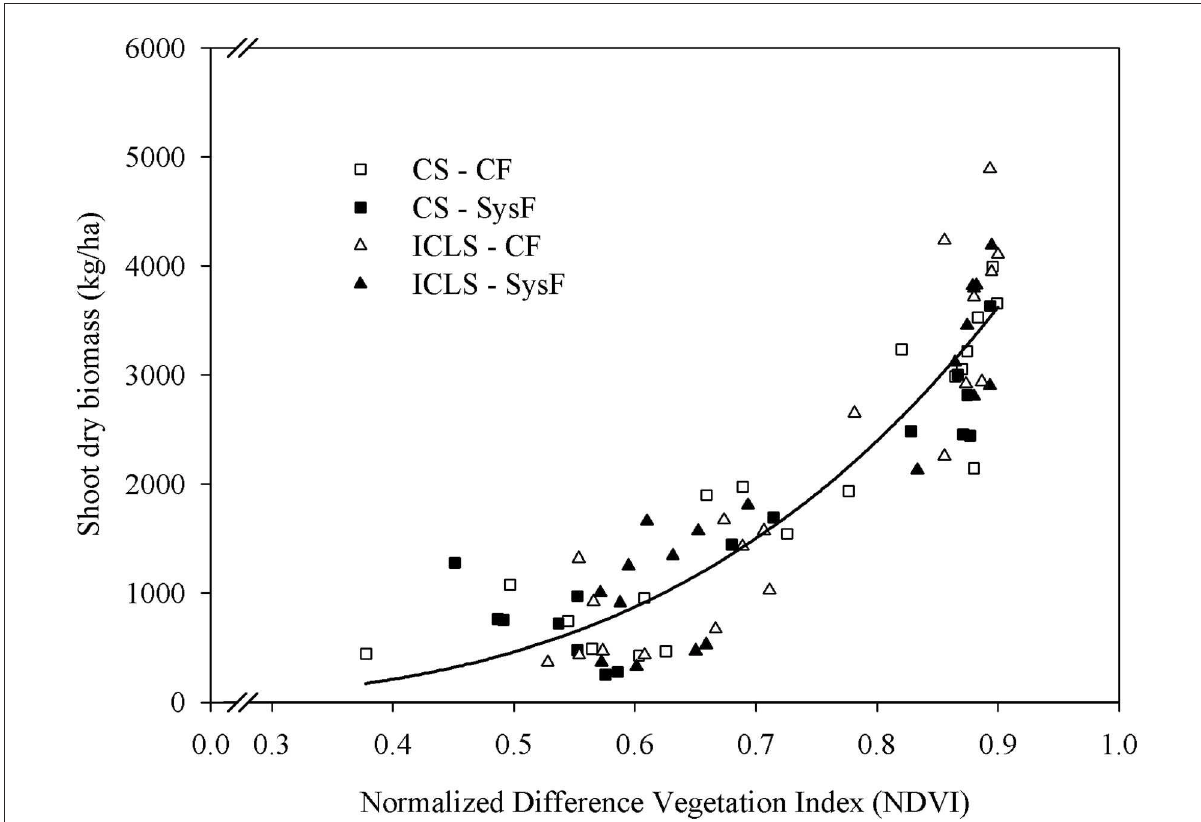
FIGURE4 Relationship between soybean shoot biomass and the Normalized Difference Vegetation Index under the cropping system with crop fertilization (CS–CF), cropping system with system fertilization (CS–SysF), the integrated crop-livestock system with crop fertilization (ICLS–CF), or the integrated crop-livestock system with system fertilization